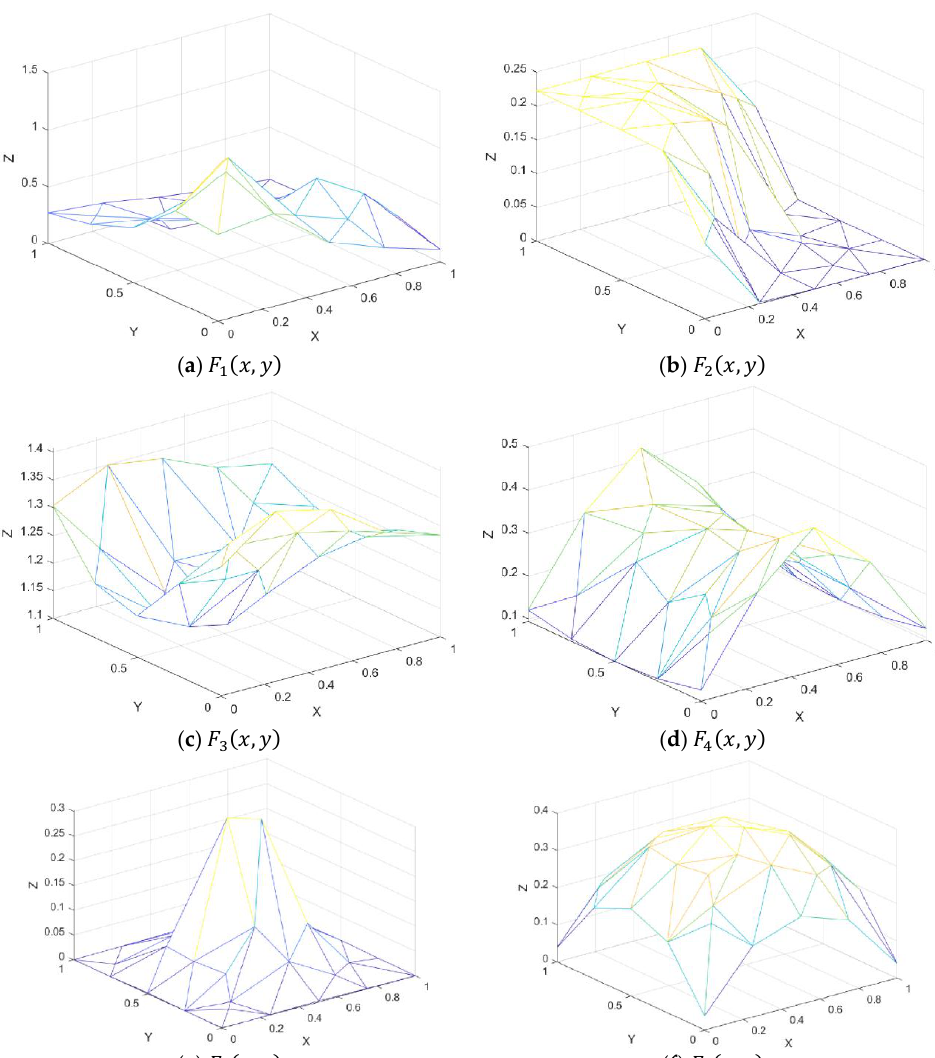
Figure 9. 3D linear interpolant for 36 datasets.